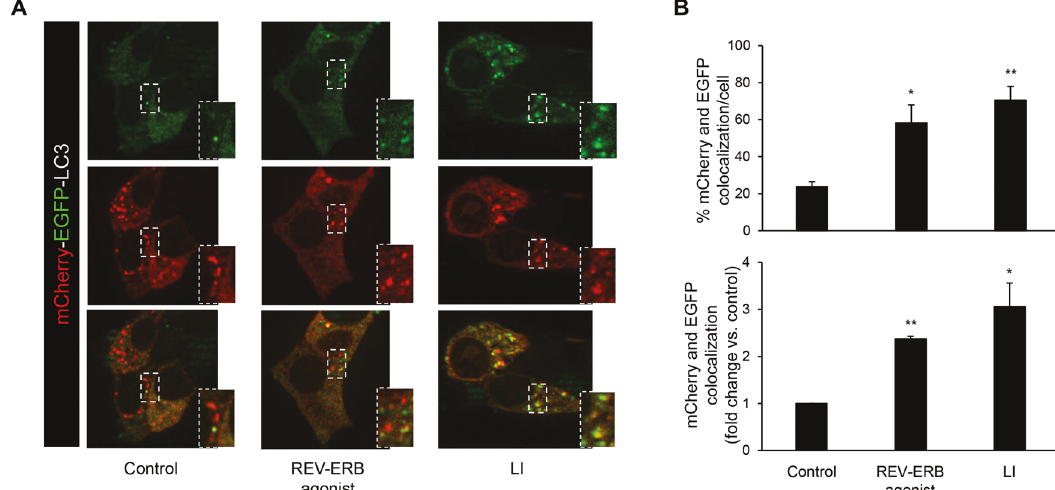
Fig. 3 REV-ERB α agonism impairs autophagic fl ux in β -cells. A INS-1E cells expressing mCherry-EGFP-LC3B plasmid were either cultured in the absence or presence of lysosomal inhibitors (LI: E-64-d, 10 μ g/ml and pepstatin A, 10 μ g/ml, 24 h), or exposed to REV-ERB agonist (SR9009, 10 μ M, 24 h) or control (DMSO). B Autophagic fl ux was assessed by quanti fi cation of mCherry and EGFP puncta colocalization using the Image J software. Results are expressed as the percentage of mCherry and EGFP colocalization per cell (top graph), and as fold change vs. control (bottom graph). Data are expressed as mean ± SEM of three to four independent experiments; * P < 0.05, ** P < 0.01 vs.